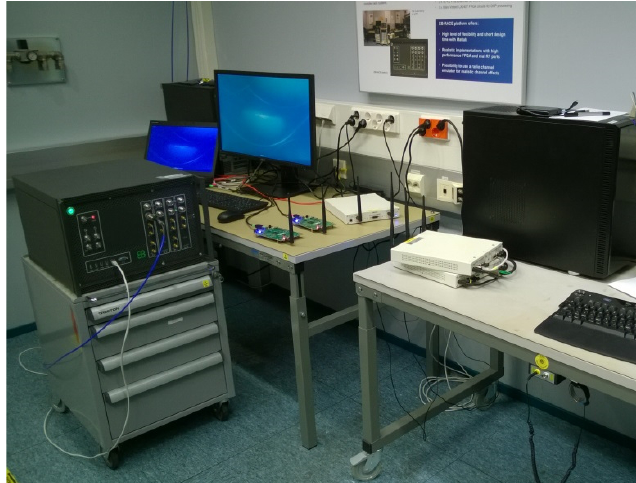
Figure 4. Demonstration